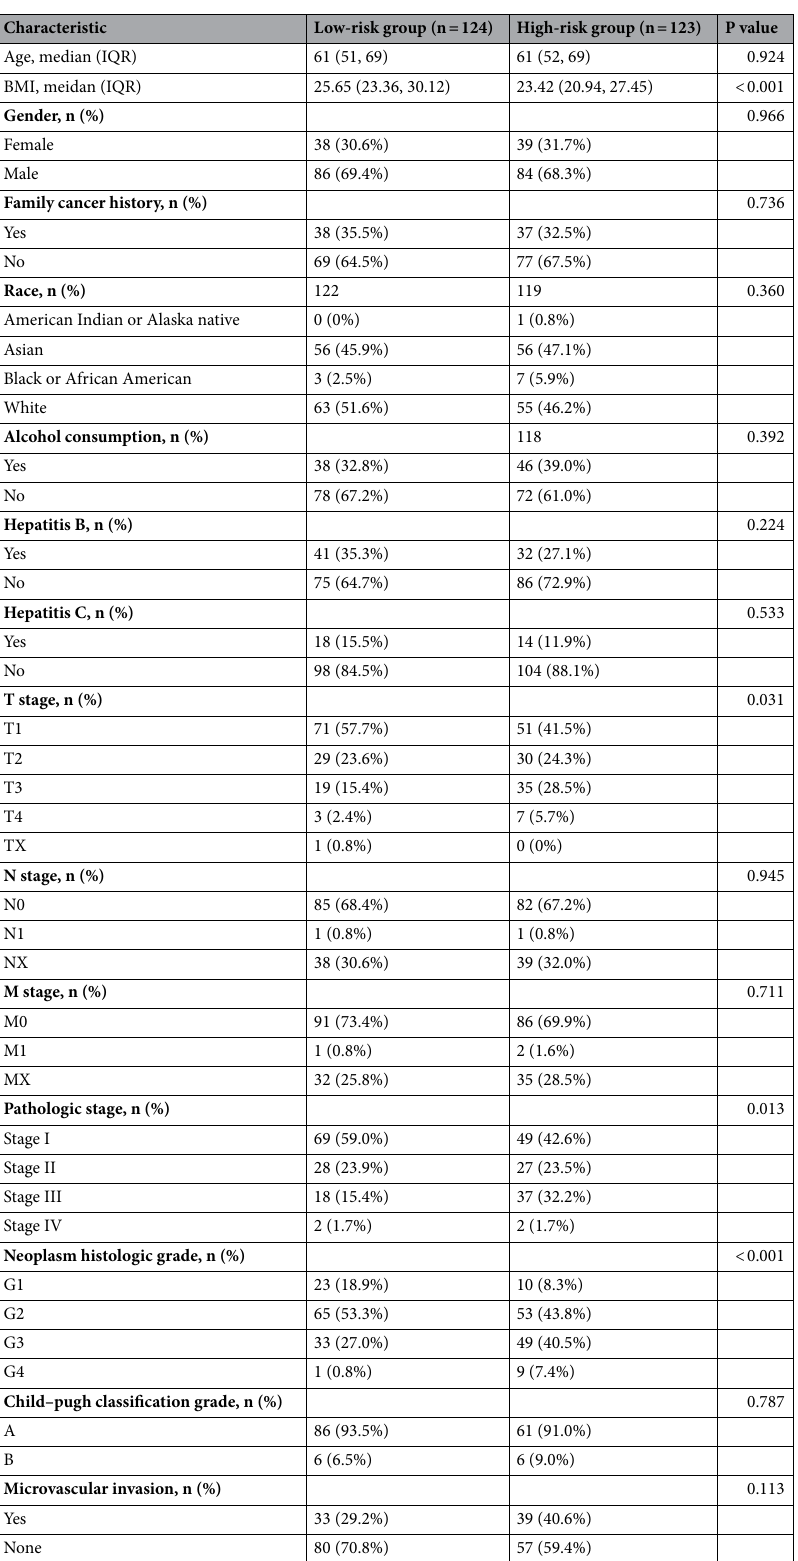
Table 2. Associations between the risk score and characteristics of HCC patients in training